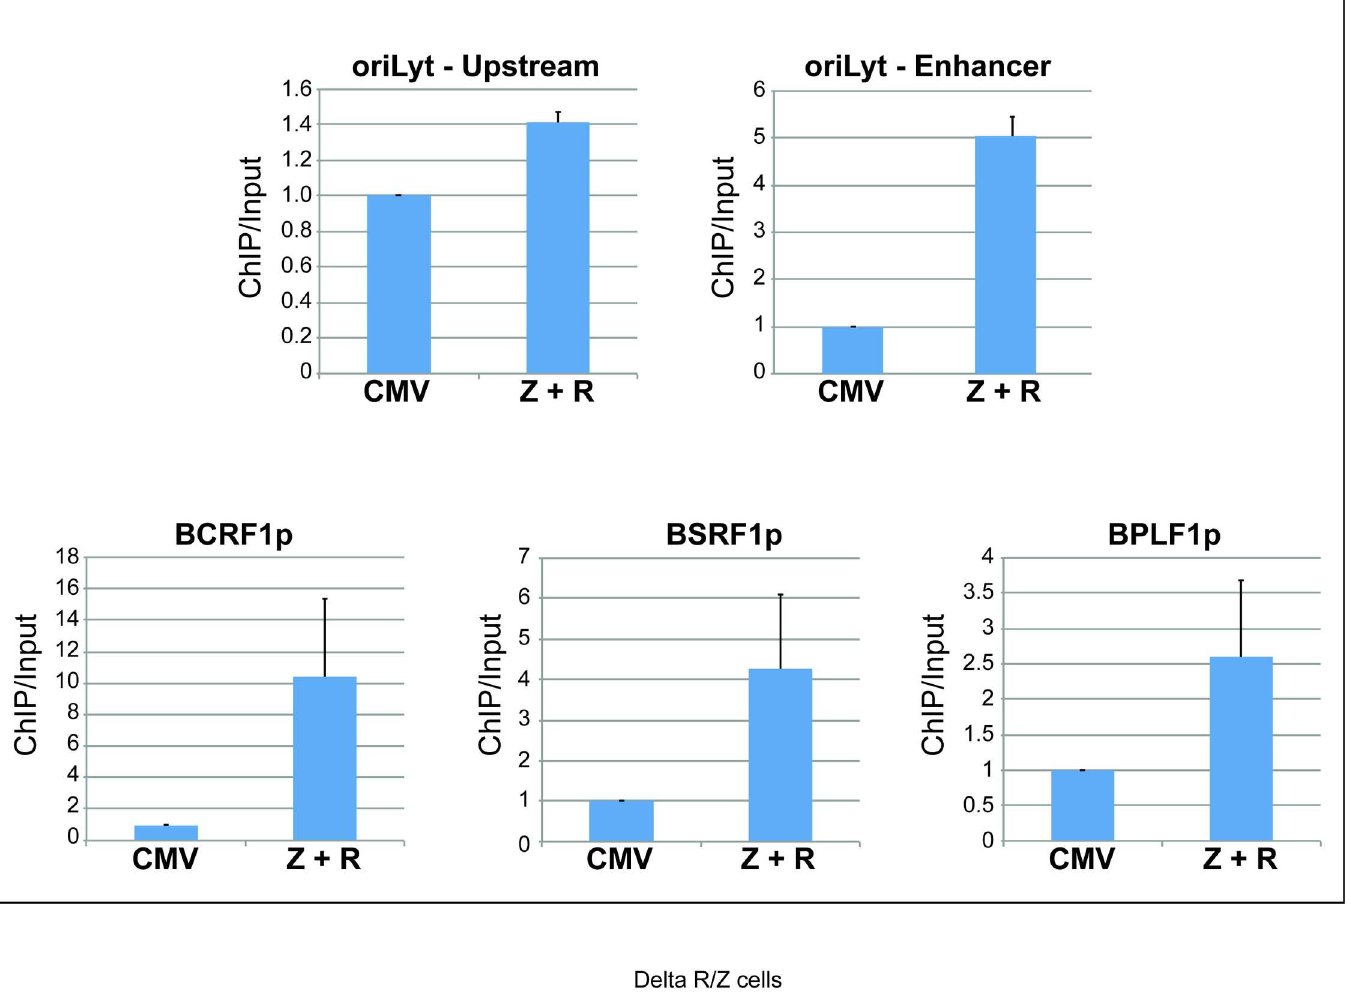
Fig 11. Rta associates with the promoters of the late BGLF3-independent BCRF1, BSRF1 and BPLF1 genes. Chromatinimmunoprecipitation examiningthe level of viral DNA co-immunoprecipitated from delta Rta/ZEBRA cells using Rta antibody. Real time PCR was used to compareassociationof Rta with the promoters of three BGLF3-independent late genes, BCRF1, BSRF1 and BPLF1. The upstream and the enhancerregions of oriLyt were used as negative and positive controls, respectively, for Rta binding.Fold associationof Rta with EBV DNA was corrected for the amount of input DNA. Z, ZEBRA; R, Rta, and oriLyt, the origin of EBV lytic